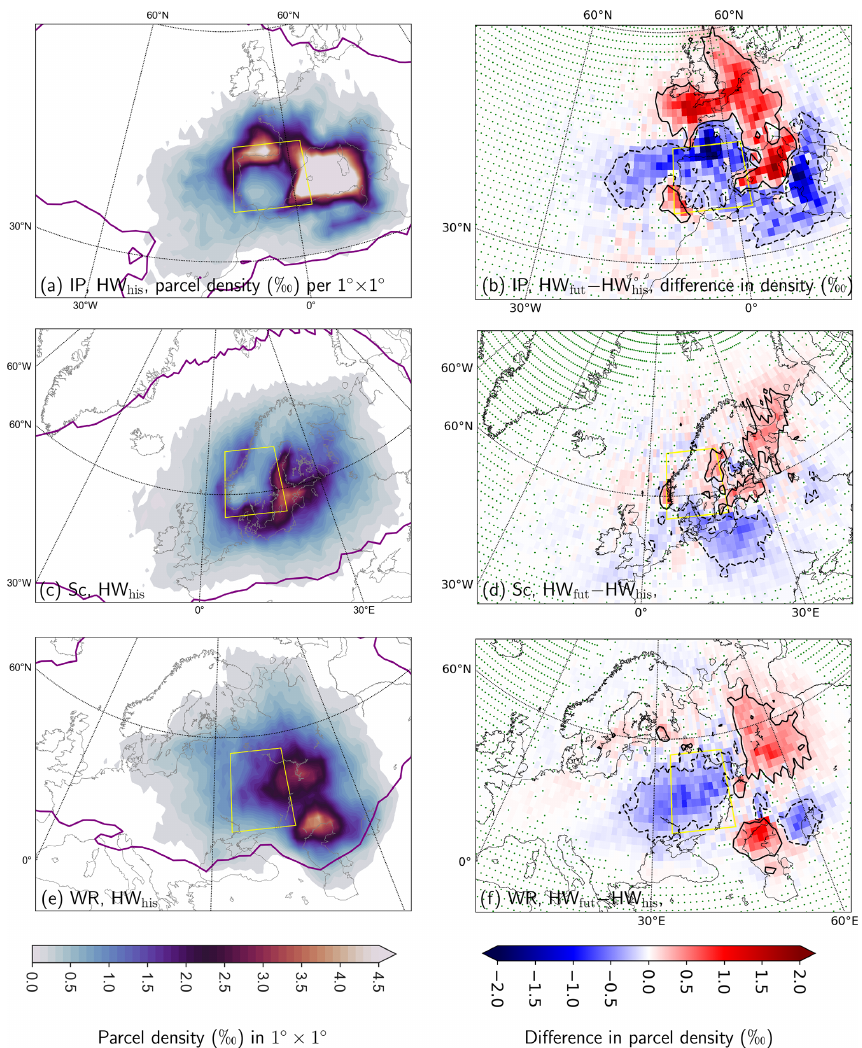
Figure 7. As in Fig. 6 but for IP, Sc and